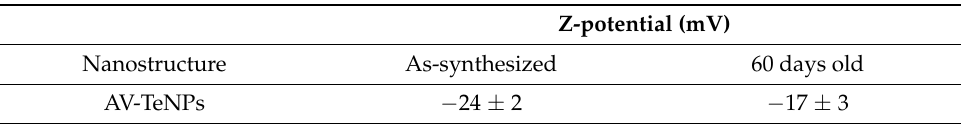
Table A1. Z-potential values for fresh and 60-day-old aloe vera-mediated tellurium